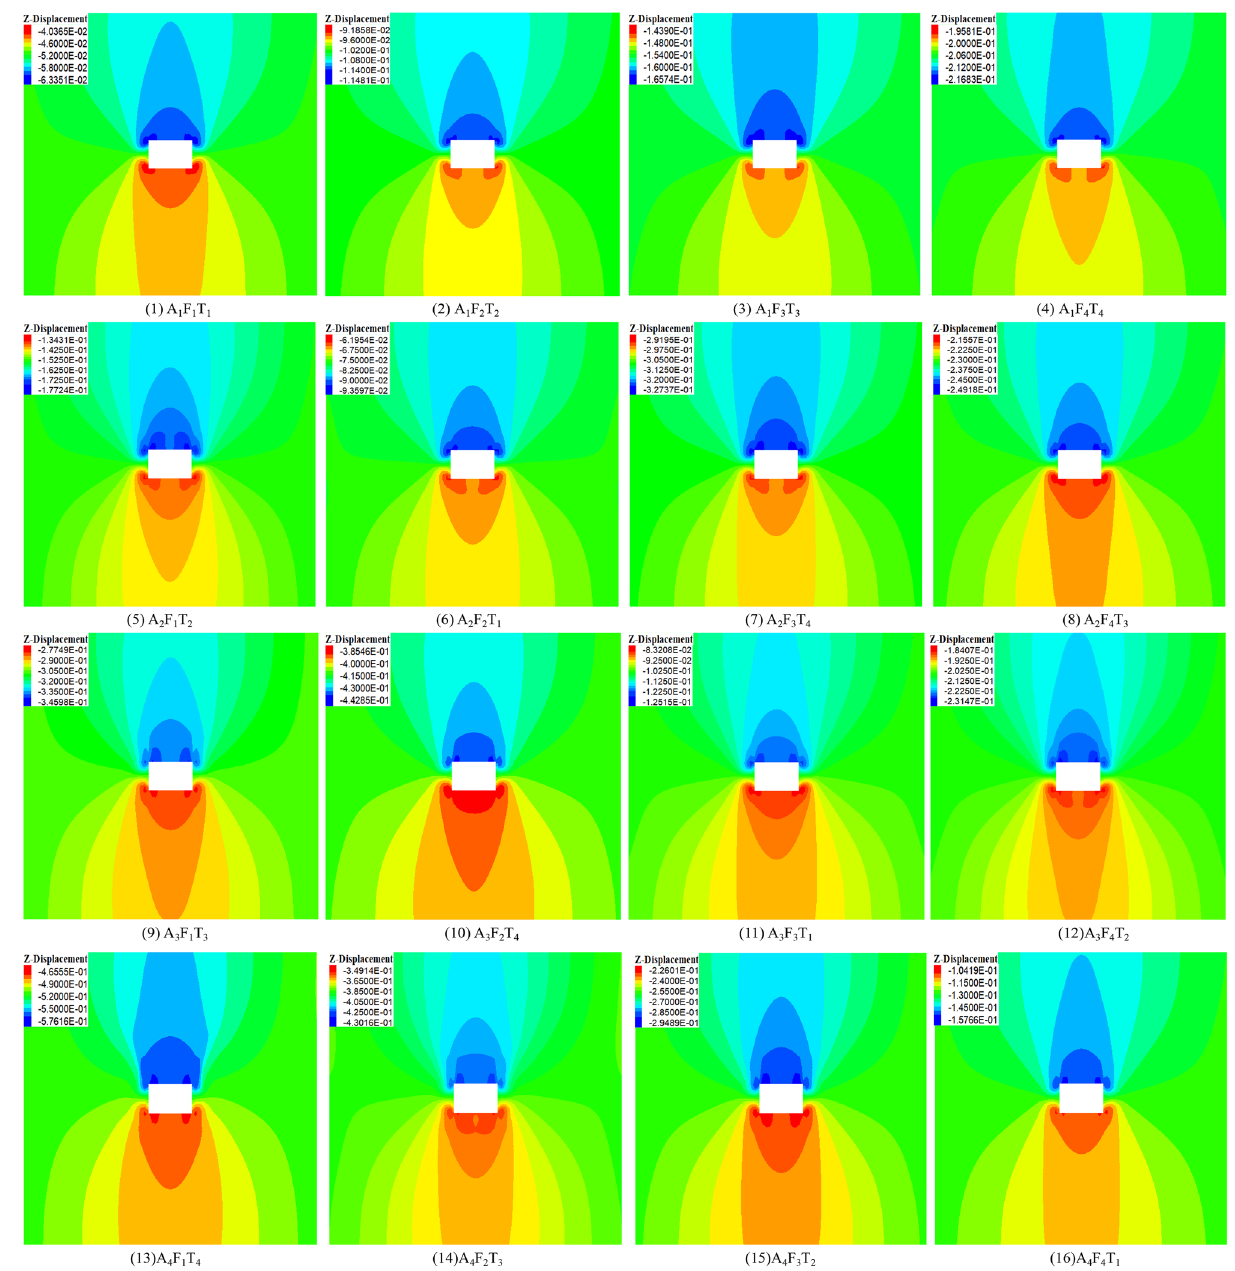
Figure 15. Deformation of surrounding rock under different